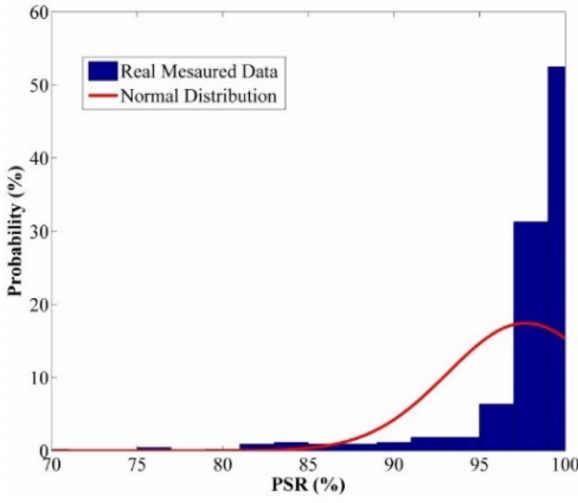
Figure 18. PSR PDF after FCI 01 location adjusted. Table 3. PSR parameters of each LS after FCI 01 location adjusted.